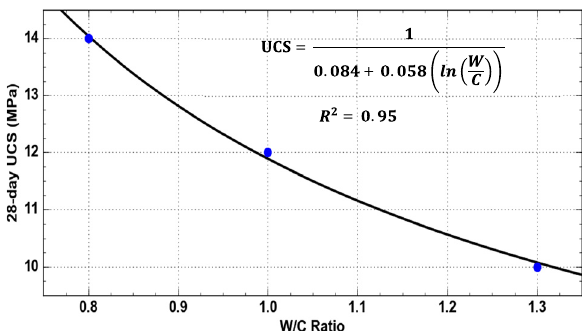
Figure 2: Uncon fi ned compression strength ( UCS ) – W/C ratio for OPC binder.